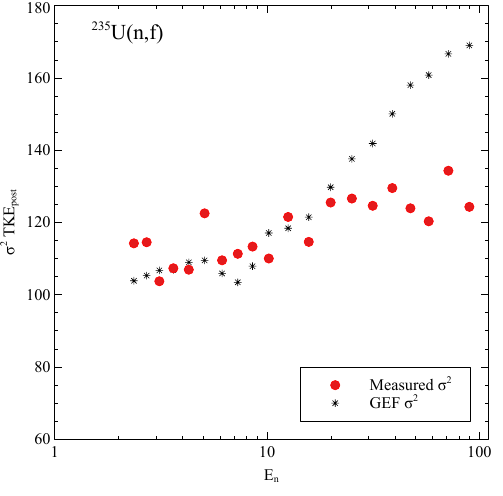
Figure 5. Measured and GEF calculated variances of the TKE distributions for the fast neutron induced fission of 235 U.